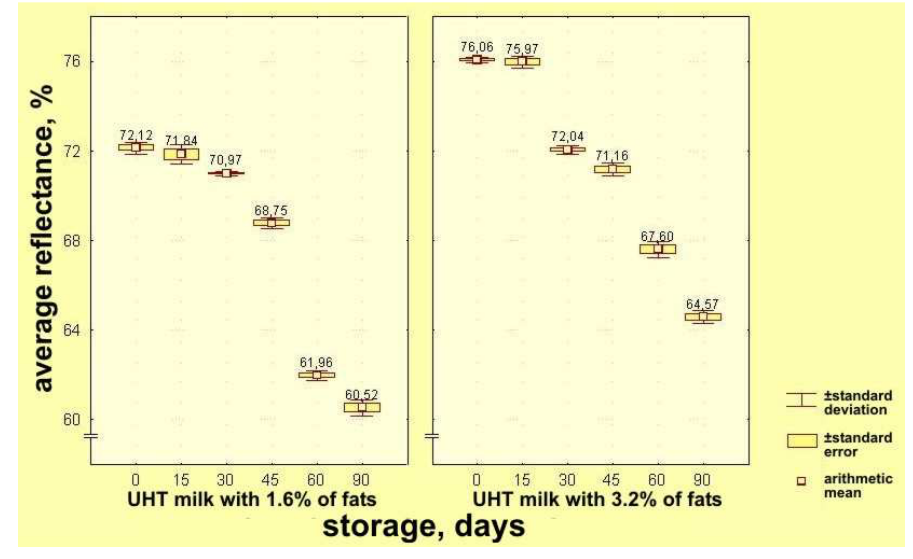
Figure 2. Effects of storage time on changes of average reflectance of UHT milk samples with 1.6 and 3.2% milk fat represented in the CIE